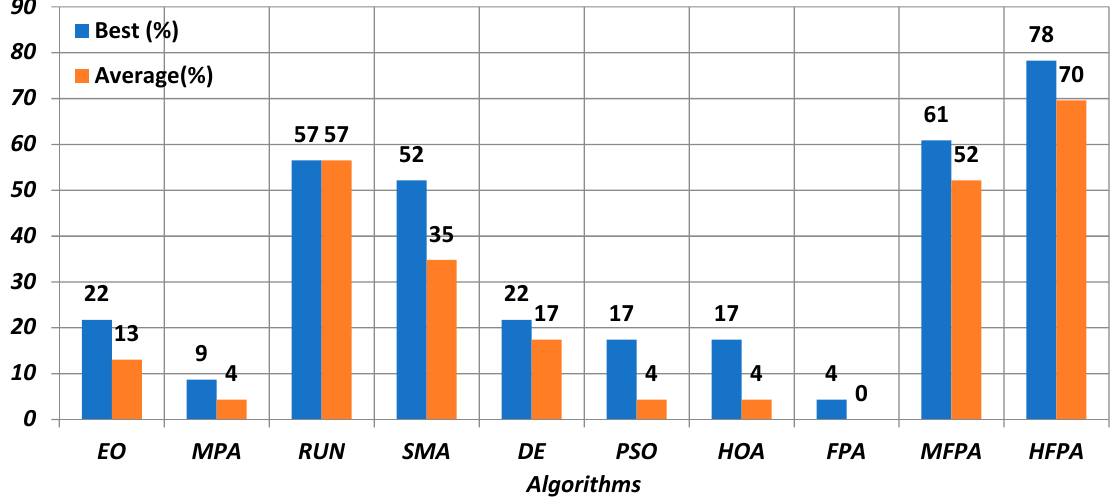
Figure 6. Outperformance and competitiveness percentage of each algorithm in terms of best and average values on global test functions.